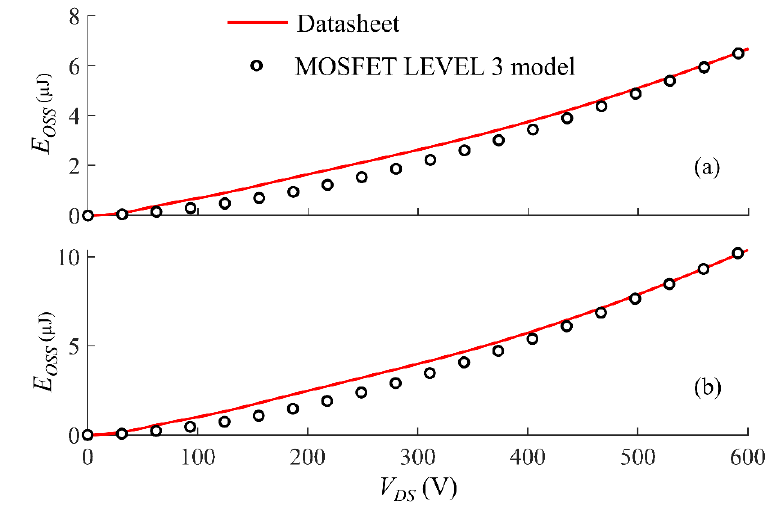
Figure 6. Energy stored in the output capacitance for ( a ) GS66504B and ( b ) GS66506T.